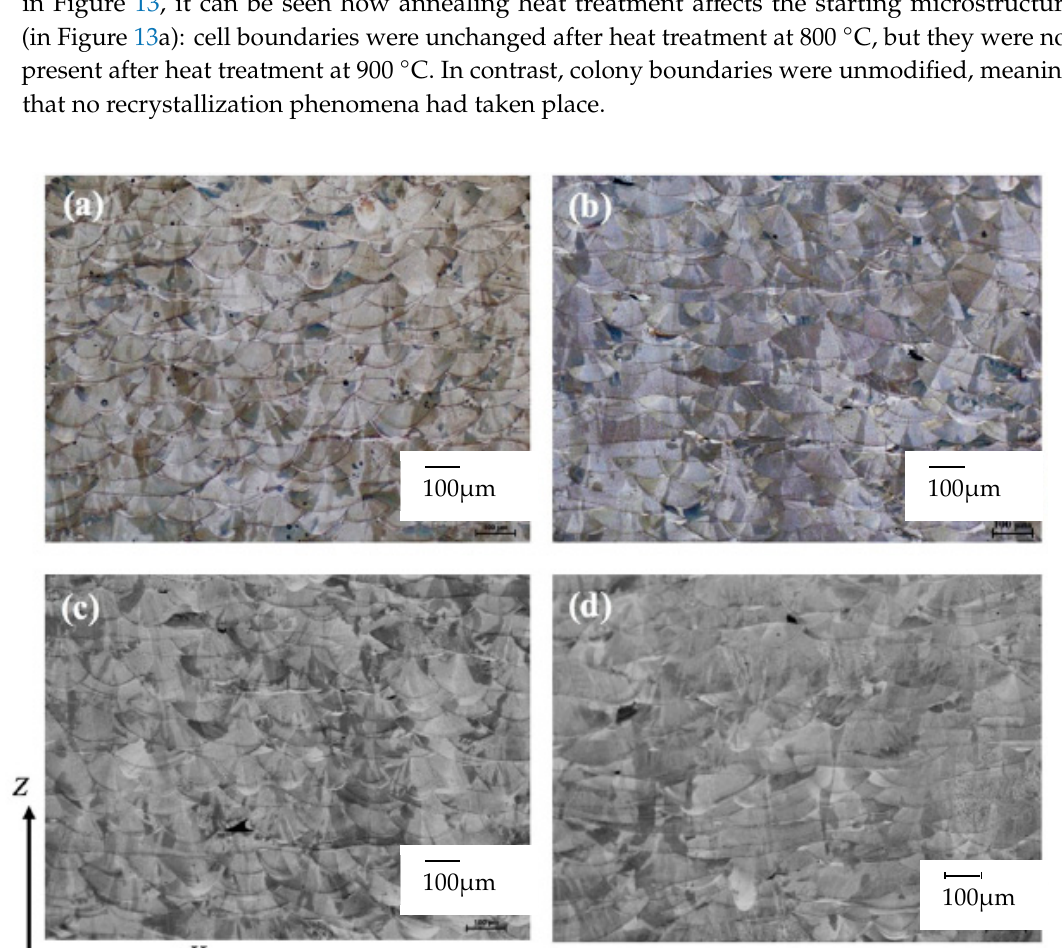
Microstructural characterization performed by [127,134,135] on both 304 and 316L stainless steels